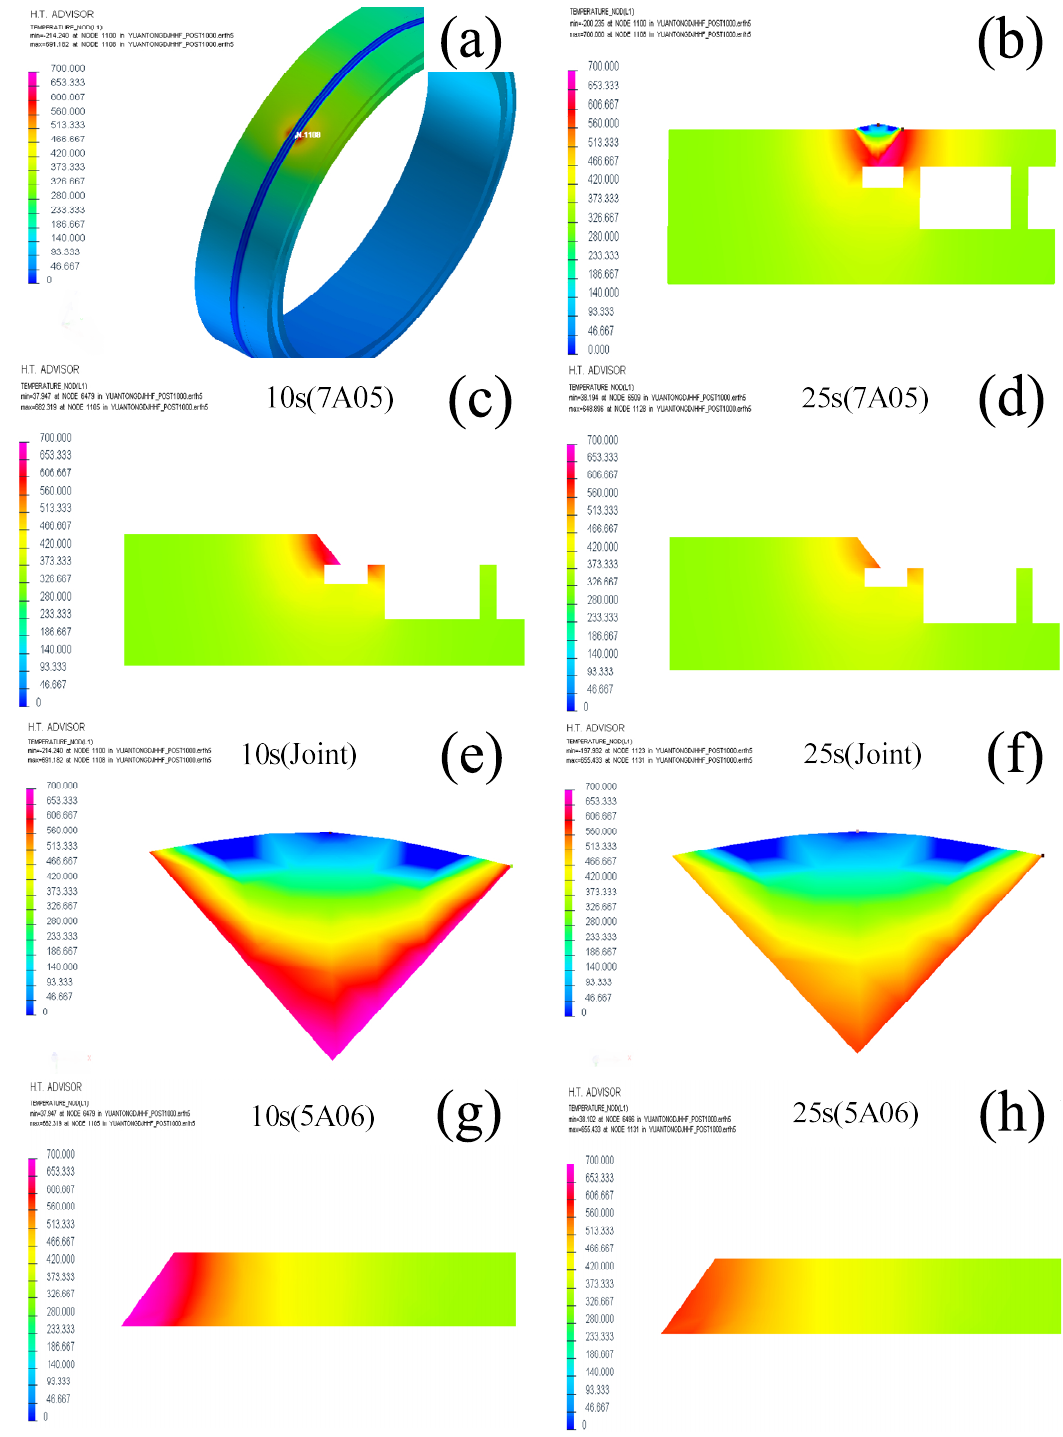
Figure 11. Temperature field distributions: ( a ) simulation of temperature field distribution of welded joints; ( b ) temperature distribution of welded joint profiles; ( c – d ) 7A05BM profile temperature field distribution; ( d , e ) weld profile temperature field distribution; ( g , h ) 5A06BM profile temperature field distribution.